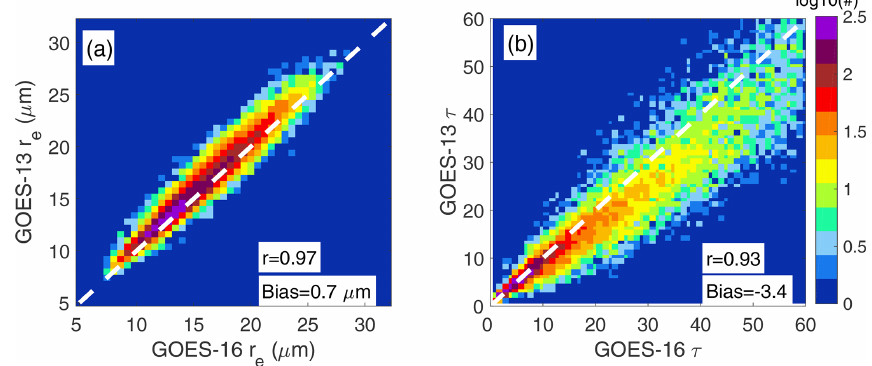
Figure 11. Relationship between 30min GOES-16 ABI and GOES-13 cloud retrievals for 5d of December 2017 (20, 22, 24, 26, 28) over the North Atlantic for solar zenith angle < 75 ◦ : (a) cloud effective radius and (b) cloud optical depth. The bias is defined as the mean difference between GOES-13 and GOES-16 retrievals.